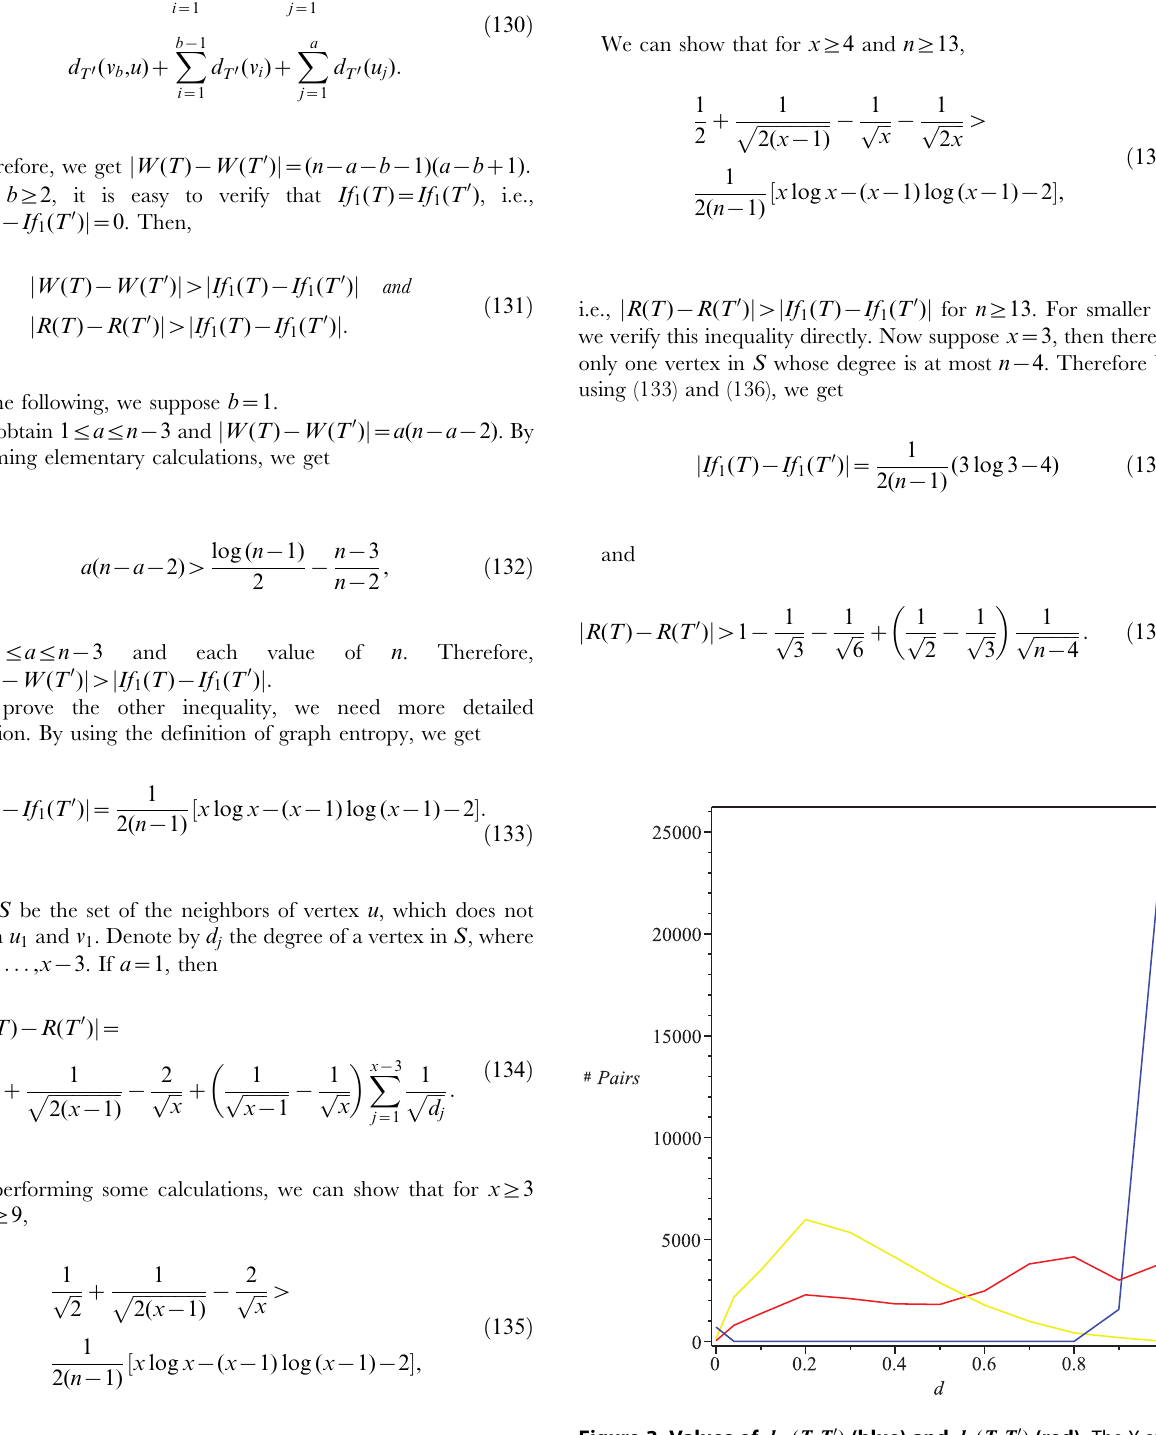
Figure 3. Values of d If ( T , T 0 ) (blue) and d R ( T , T 0 ) (red). The Y-axis 1 denotes the values of the distance measure and the X-axis denotes the graph pairs.